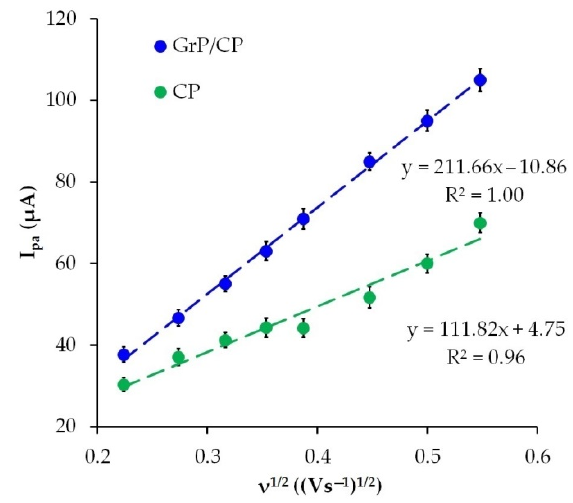
Figure 6. The plot of I pa vs. ν 1/2 for CP and GrP/CP electrodes.